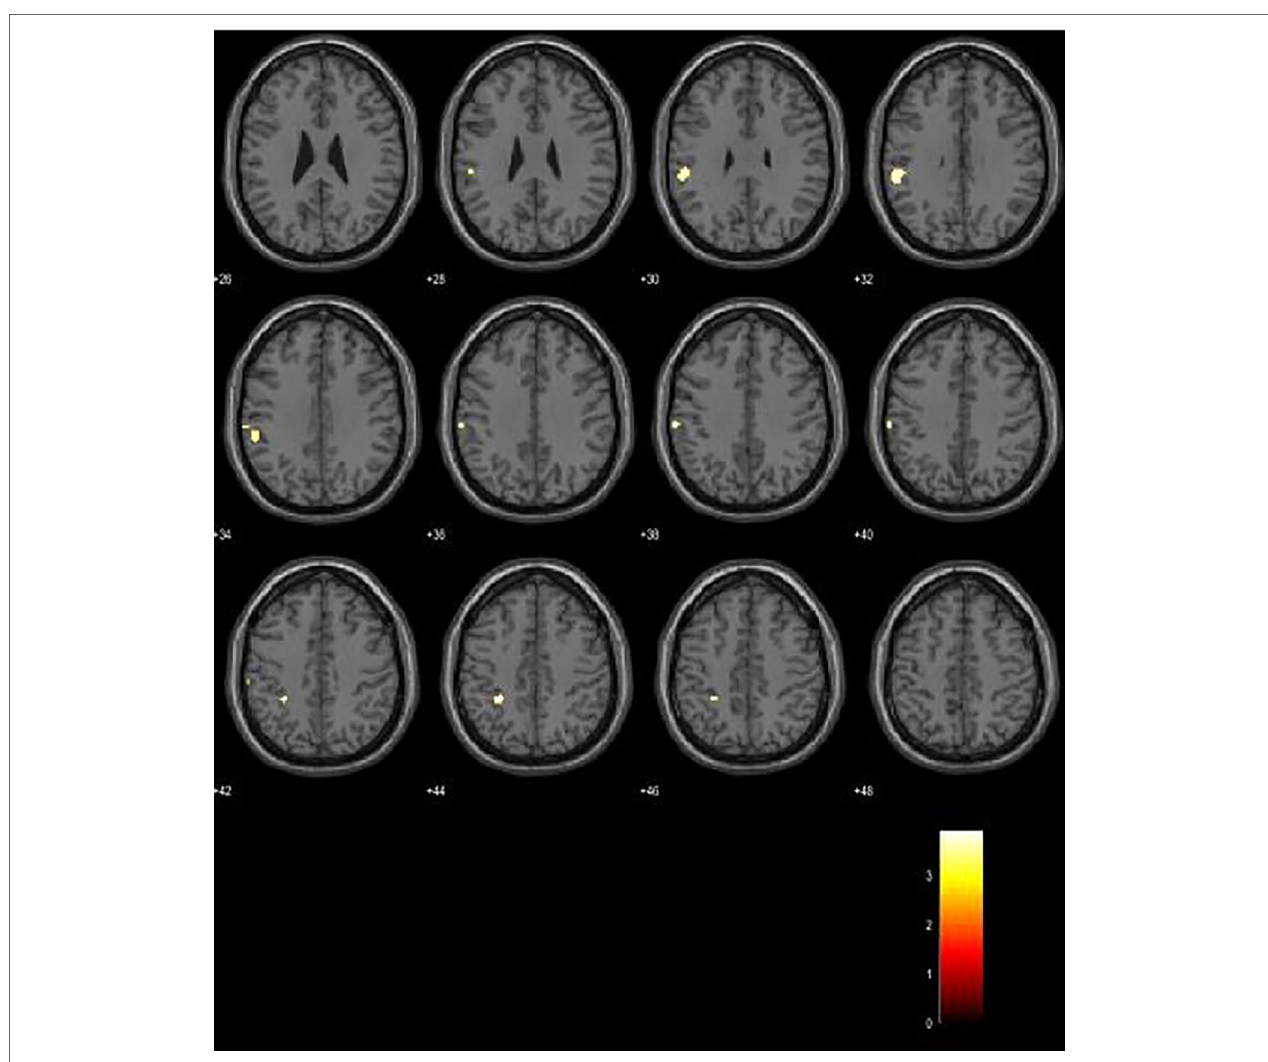
FIGURE 1 | Between-group analysis revealed increased BOLD signal in CP